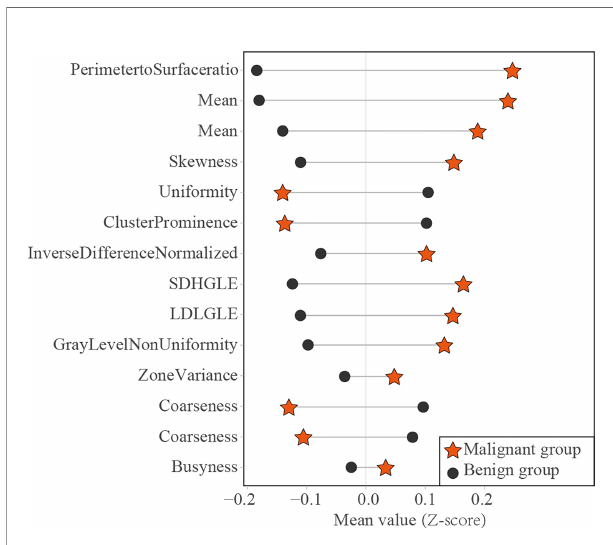
FIGURE 6 | Dumbbell diagram of the mean value of 14 useful radiomics features between the malignant and benign groups in the training set. SDHGLE, small-dependence high gray-level emphasis; LDLGLE, large- dependence low gray-level